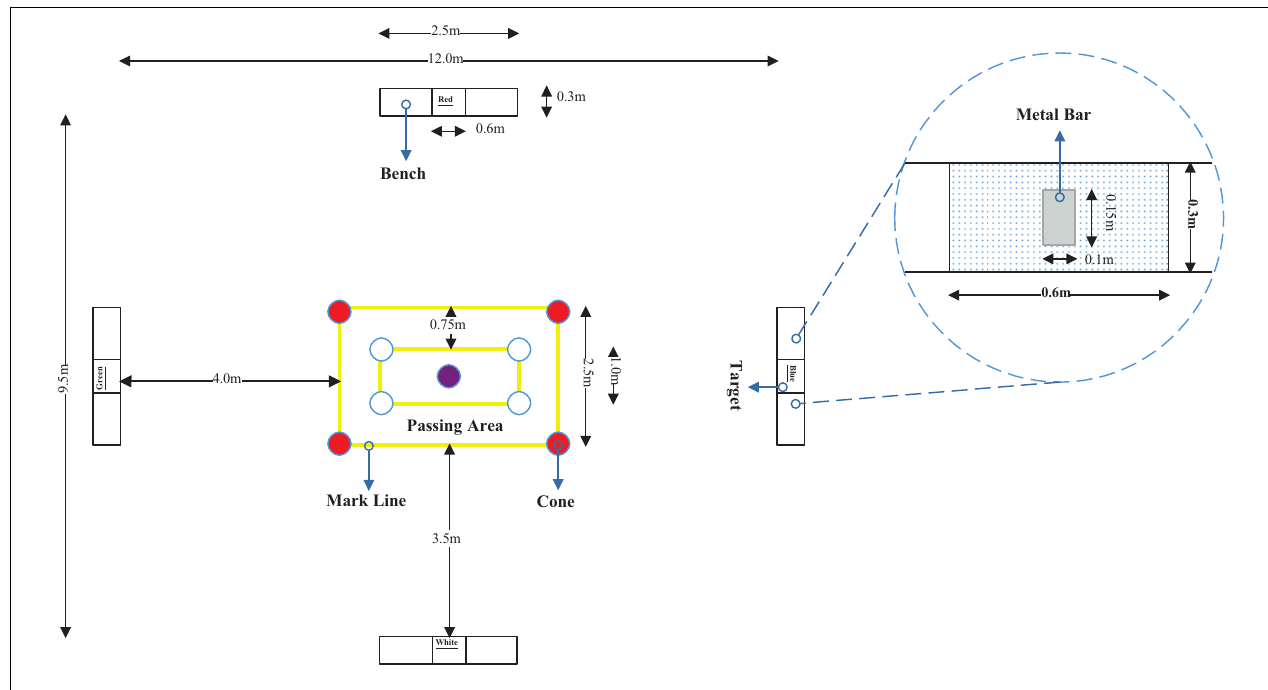
FIGURE 2 | Schematic representation of the Loughborough Soccer Passing Test (LSPT).